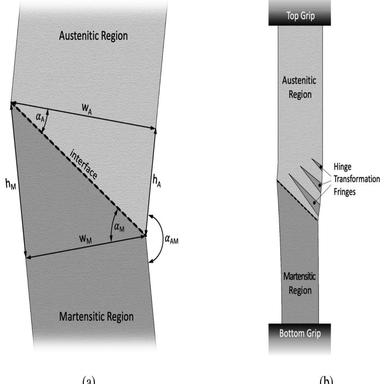
Schematic representation of the region of interface between the austenitic and martensitic regions (a), and of the full specimen in the transformation plateau region (b).